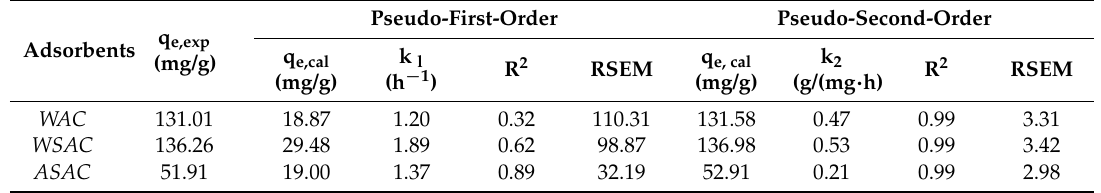
Table 4. Adsorption kinetic parameters of BPA onto ACs in single solution. q e,exp Adsorbents